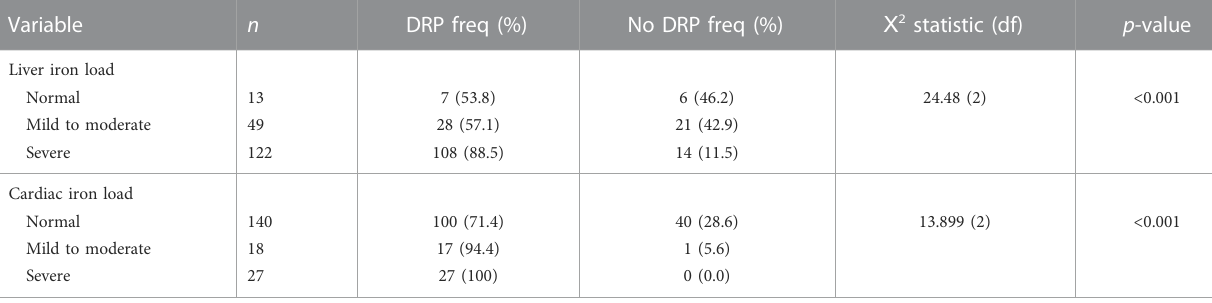
TABLE 4 Association between cardiac and liver MRI results with DRP status ( n = 200).